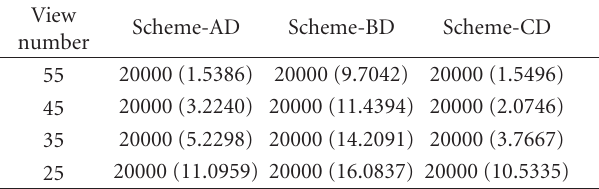
Table 3: Same as Table 1 but for projection data bearing 0.1% Gaussian